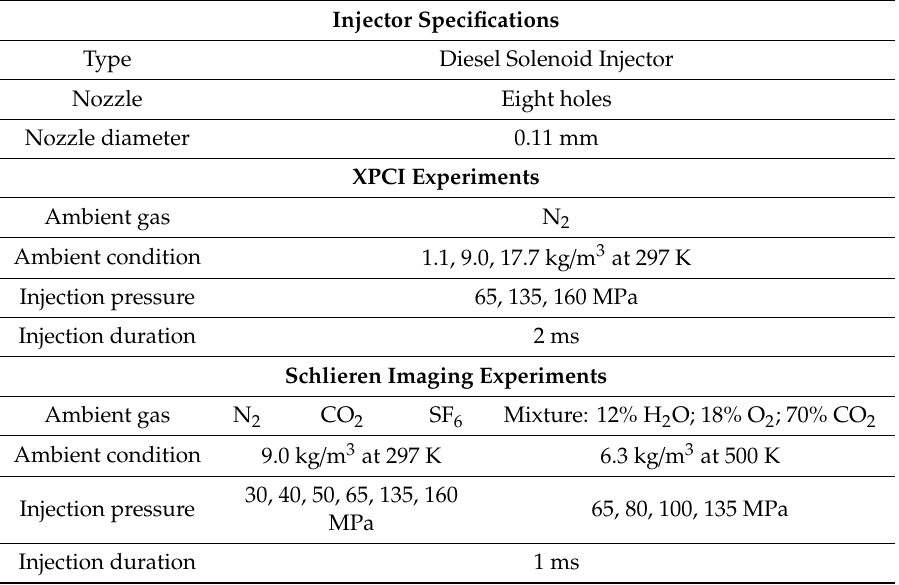
Table 1. Experimental conditions.